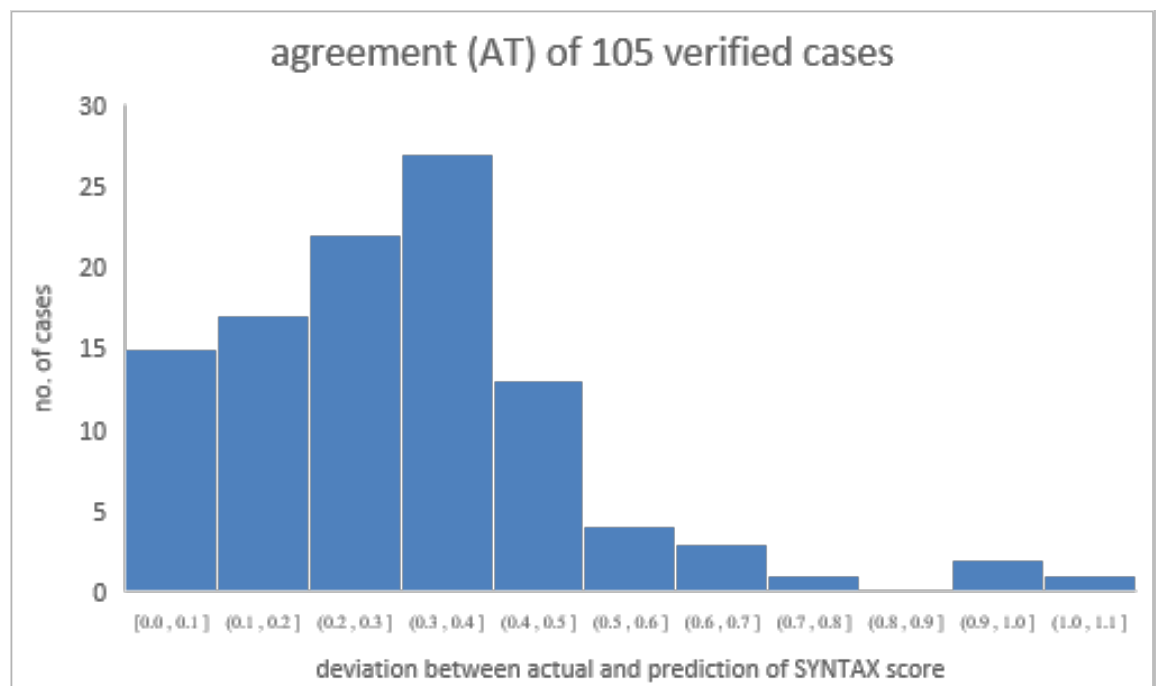
Figure 5. The actual and predicted SYNTAX scores for the original 405 patients and verified 105 patients, according to the STATISTICA 7.0-derived linear regression.